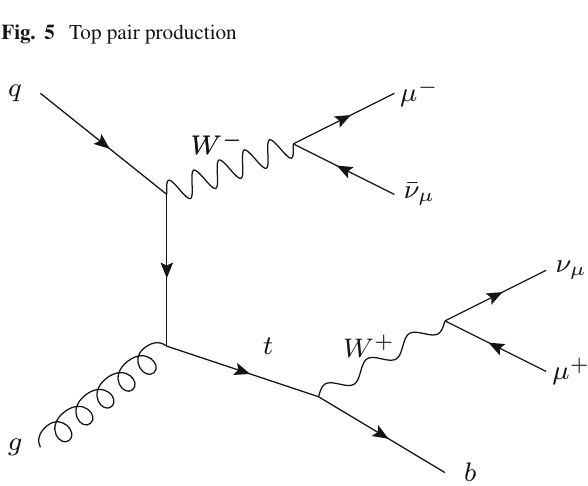
association with a W boson ( Wt ) and di-boson production ( W + W − ), where top quarks decay leptonically to muons.